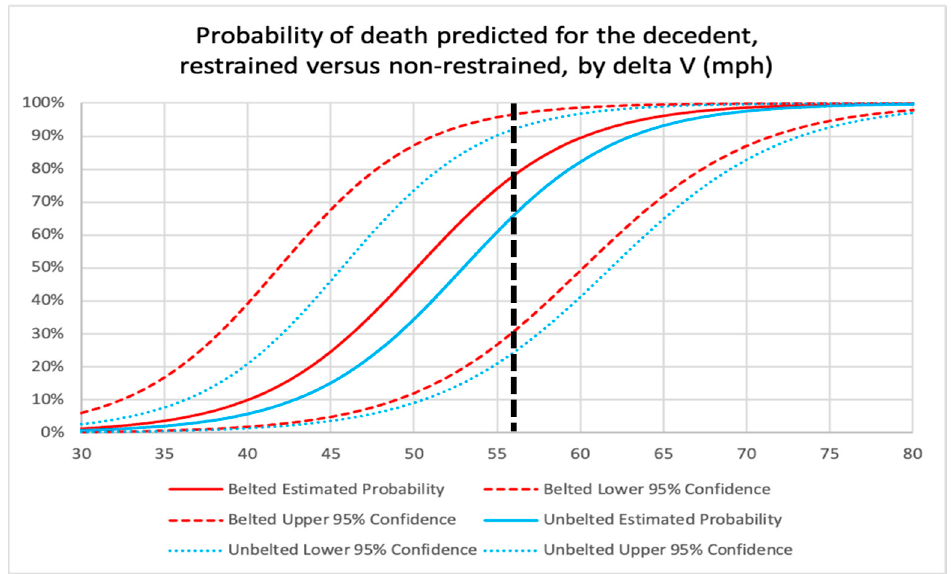
Figure 7. Chart depicting results of the logistic regression analysis, with risk curve for death by delta V, for restrained vs. unrestrained drivers. V, for restrained vs. unrestrained